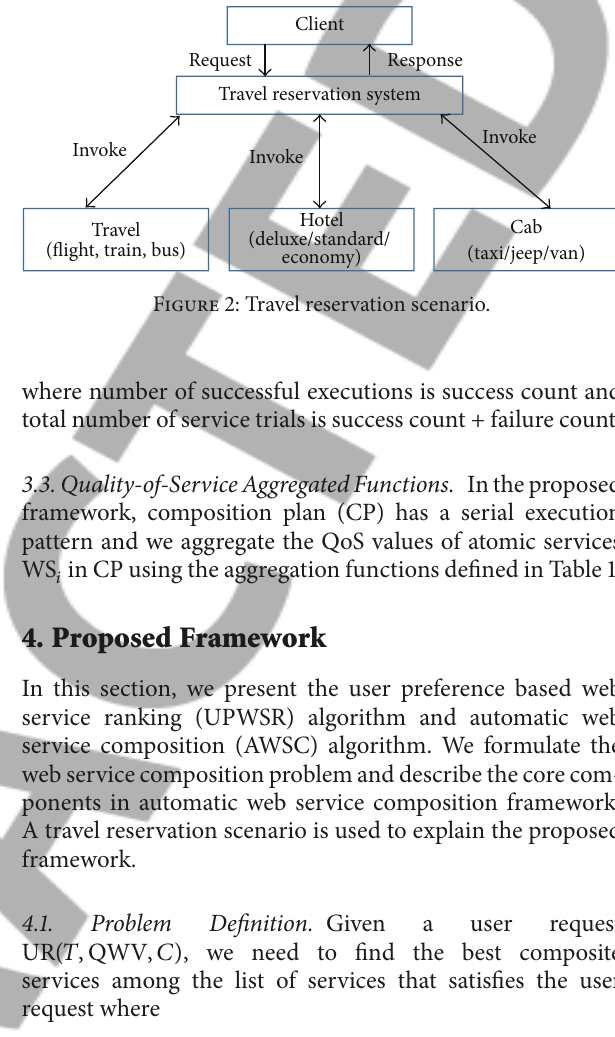
Table 1: QoS aggregation function.